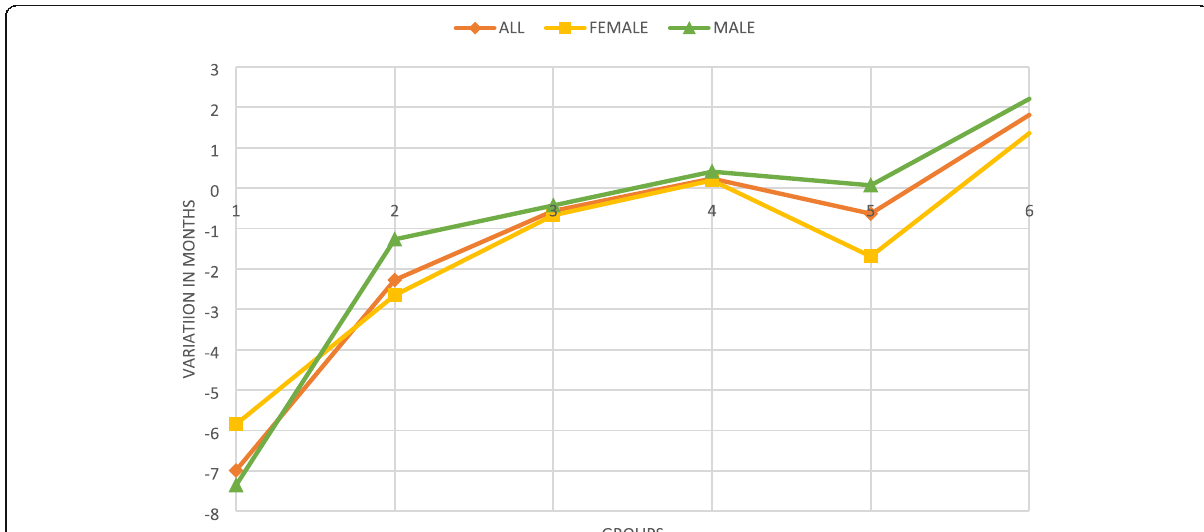
Fig. 2 Graph showing age-wise comparison of the differences of the mean dental age (using Nolla ’ s method) and mean chronological age in all the subjects in our